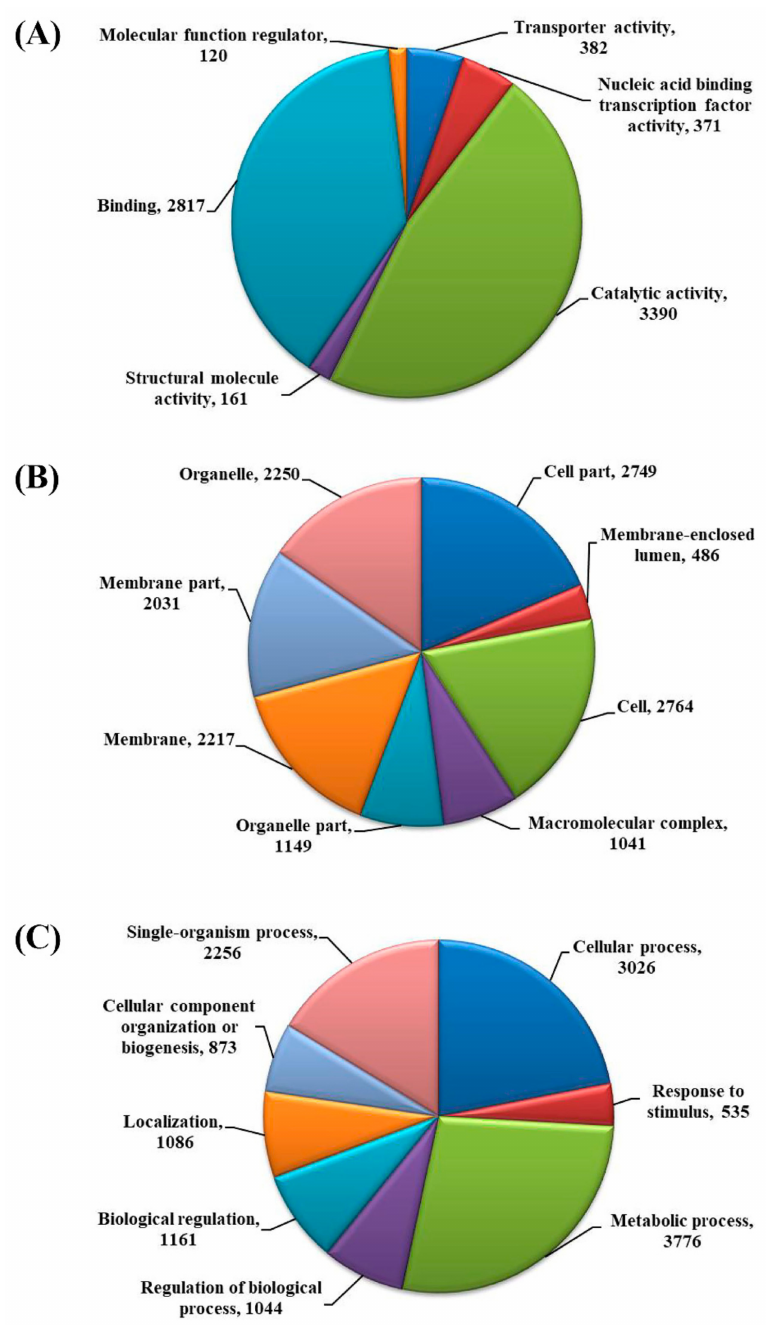
Figure 1. Gene ontology (GO)-based functional annotation of genes present in the T. asperellum ND-1 genome. ( A ) Molecular function domain (MF); ( B ) cellular process domains (CC); ( C ) biological process domains